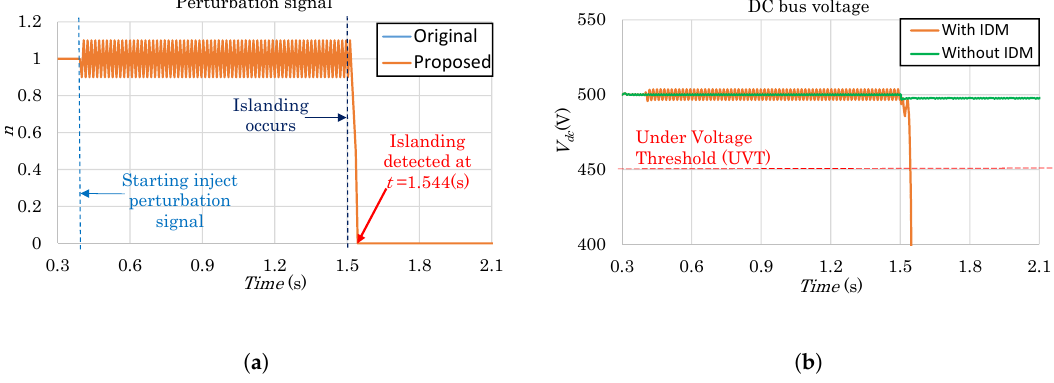
Figure 10. Result in case of single PV operation, 50 kW PV, hardest islanding condition: ( a ) Perturbation signal and ( b ) DC bus voltage (with and without IDM).